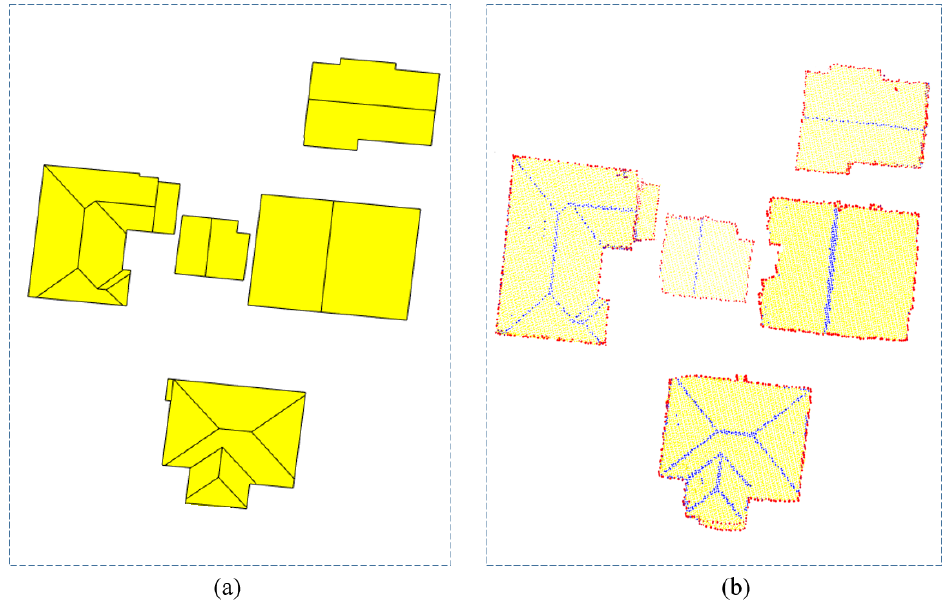
Figure 13. Combined fold (blue), boundary (red), and planar (yellow) points compared with the reference 3D building roof [7] for all five buildings from the AV1 dataset: ( a ) reference 3D building roofs and ( b ) combined results.